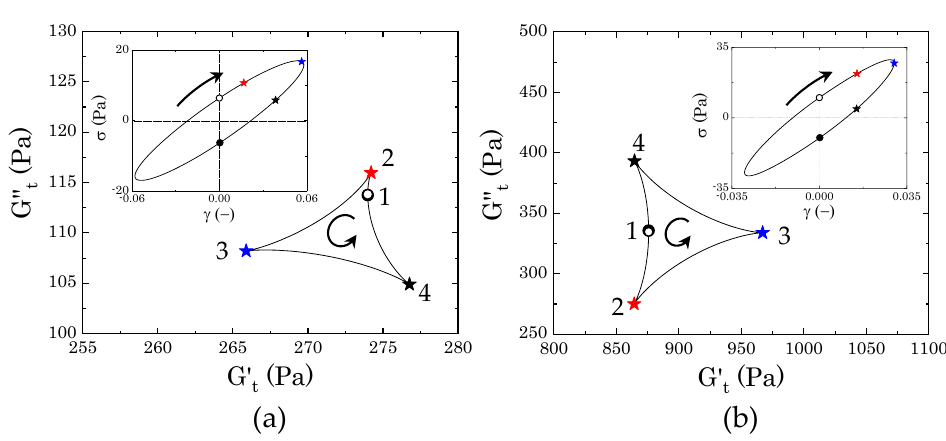
Figure 9. ( a ) Cole–Cole plot obtained at γ 0 = 0.057 (beginning of the deviation from the linear viscoelastic region) for sample M0 at 2% wt of Carbopol. ( b ) Cole–Cole plot obtained at γ 0 = 0.03 (beginning of the deviation from the linear viscoelastic region) for sample M2 at 2% wt of Carbopol. The insets show the corresponding elastic Lissajous–Bowditch plot (i.e., stress vs. strain) for